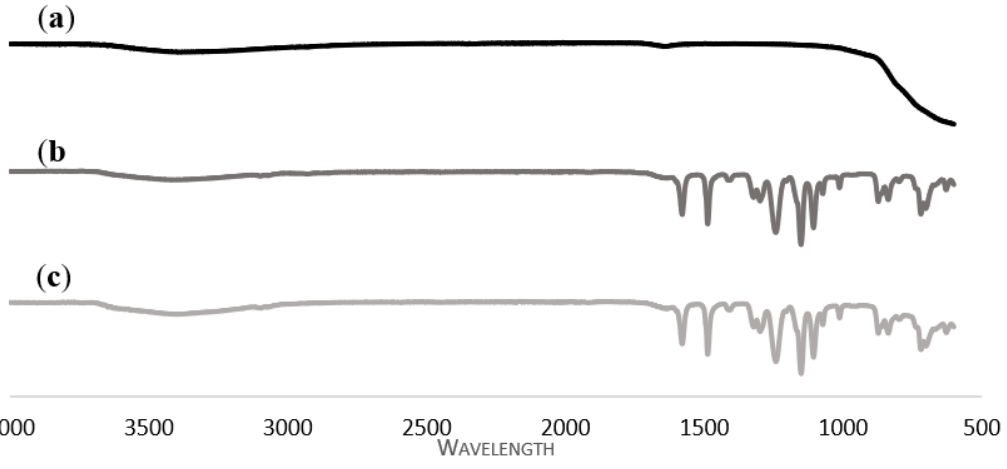
Figure 3. ATR-FTIR spectra of ( a ) TiO 2 photocatalyst; ( b ) a neat PES membrane; and ( c ) a TiO 2 /PES mixed matrix membrane.